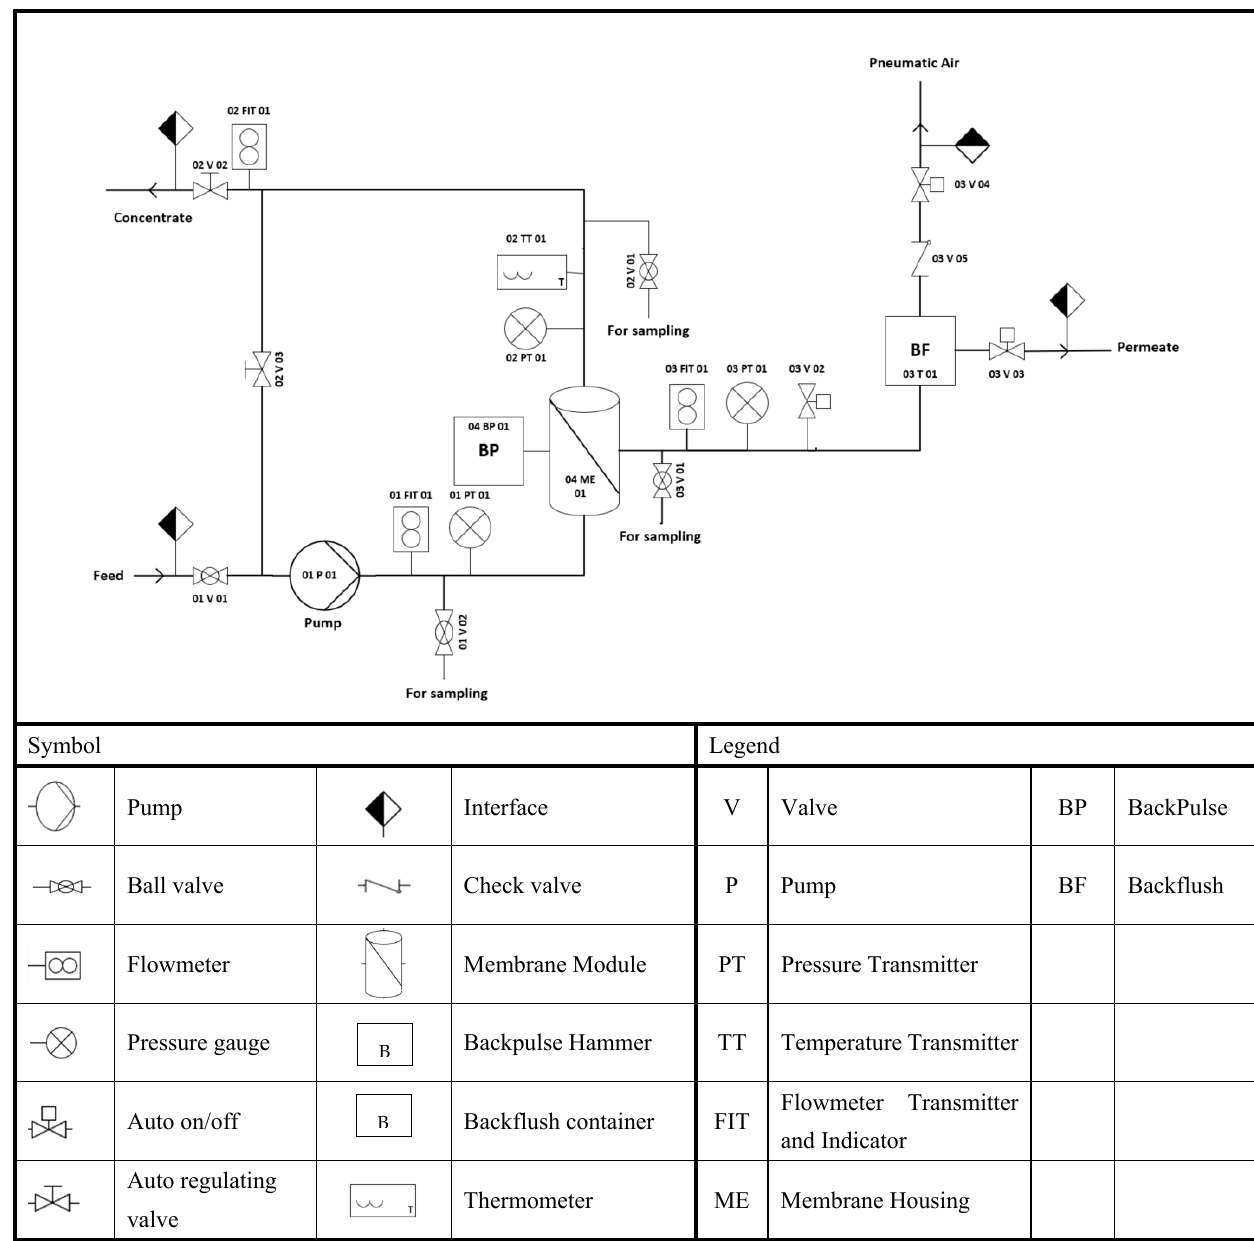
Figure 4. LabBrain P&I Diagram, adapted from [45].